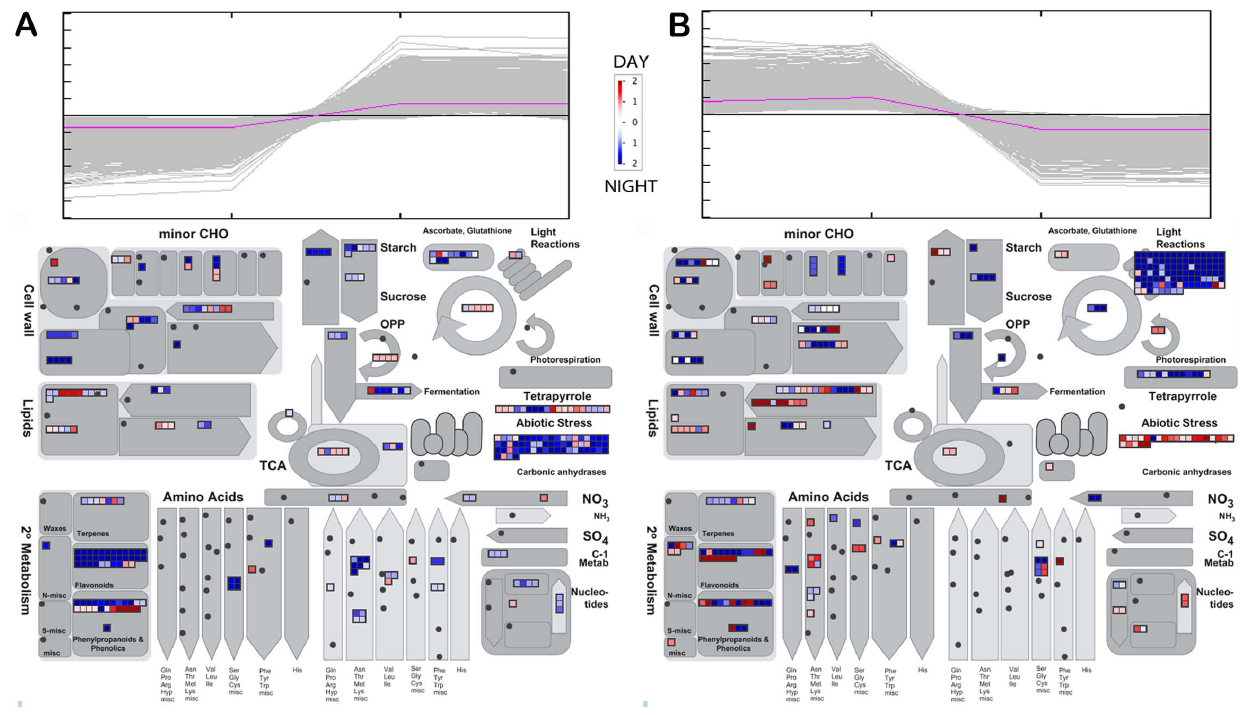
Figure 4. Example of genes allocated to illustrated clusters (4A: cluster 1 and 4B: cluster 2) specifically during day (red) or night (blue). Scales are log 2 values calculated between G2 and R1.